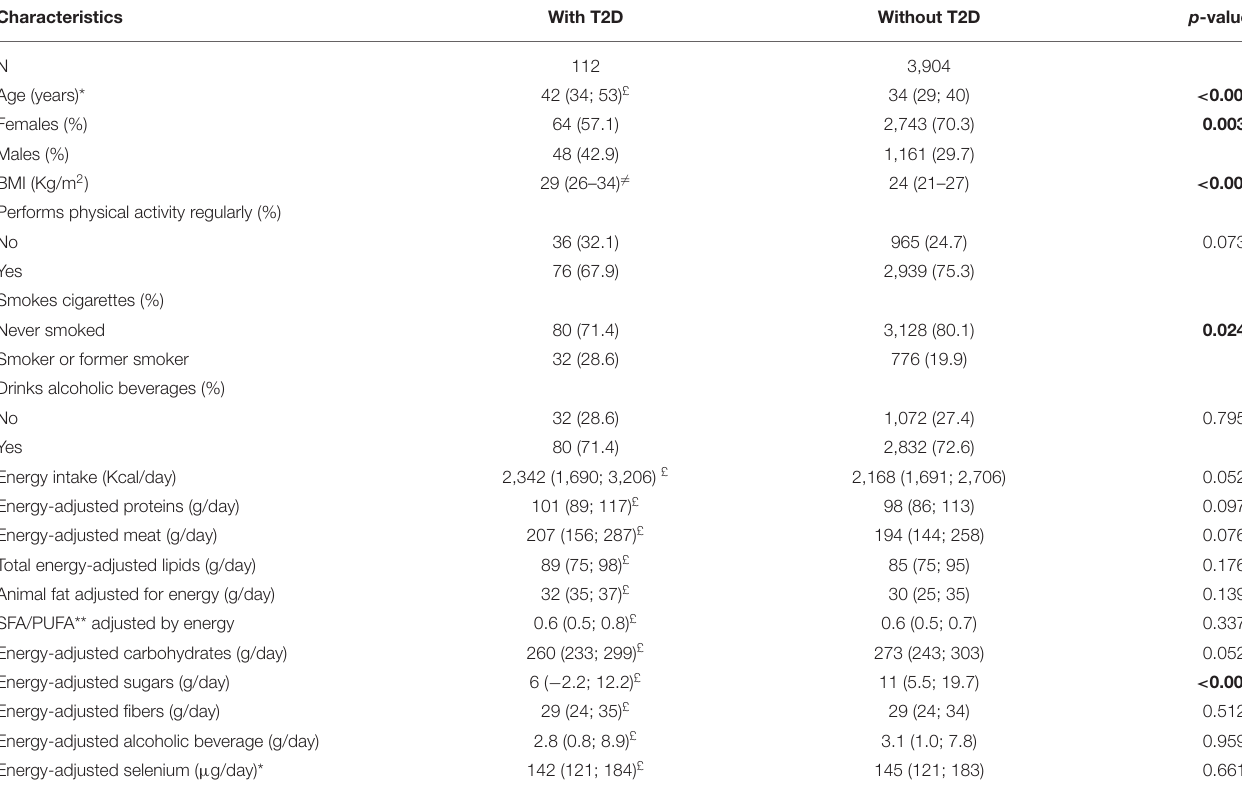
TABLE 1 | Characteristics of the study population according to type-2 diabetes status ( n = 4,016). Characteristics With T2D Without